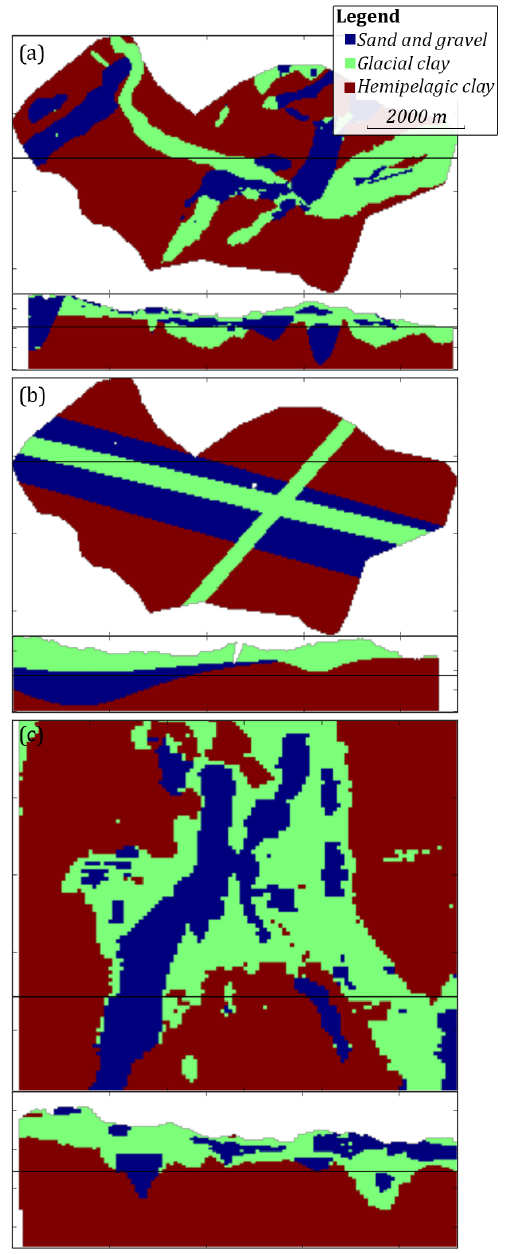
Figure 4. An overview of the training images (TIs) which are used during MPS simulation. A horizontal slice and vertical cross sec- tion is presented for each TI, portraying the hydrostratigraphic ar- chitecture; (a) shows the Kasted TI, (b) shows the conceptual TI, and (c) shows the Egebjerg TI, which is generally larger than the Kasted